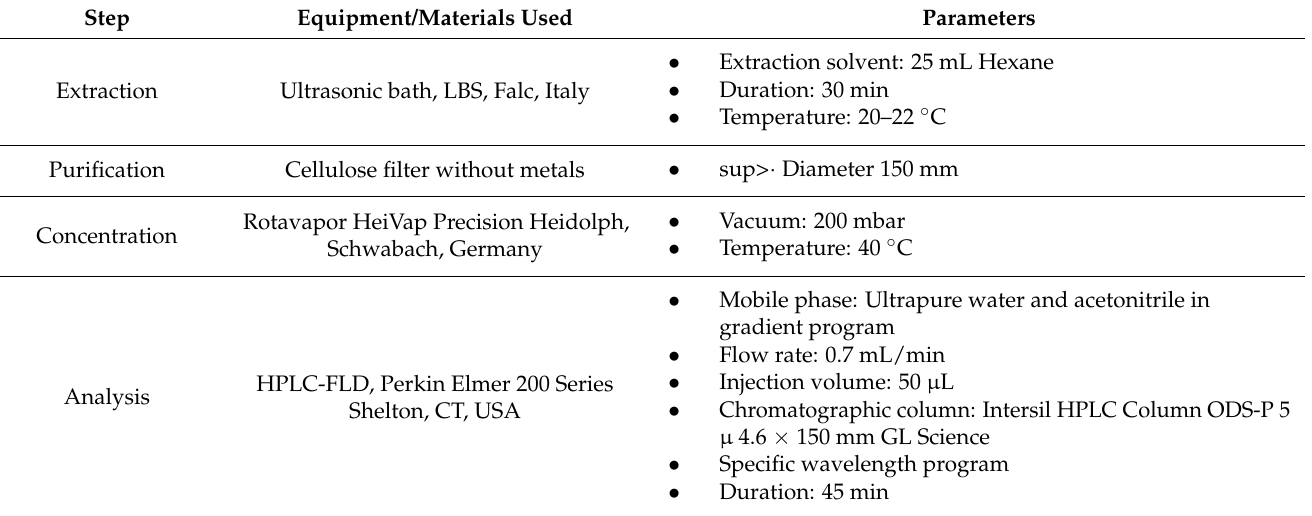
Table 3. Stages and parameters of the PAHs determination